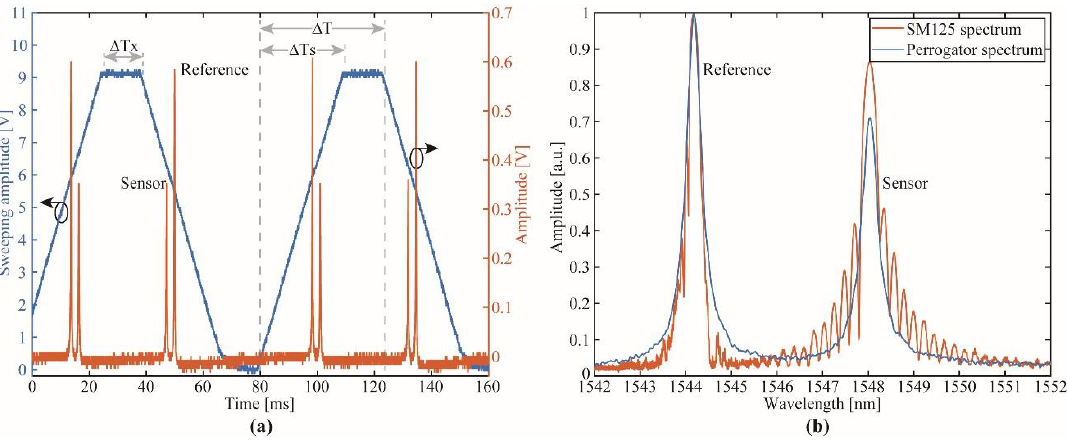
Figure 6. Spectral characterization of the FBG sensor: ( a ) Temporal response of the system; ( b ) optical spectra of both the SM125 interrogator and the proposed approach.